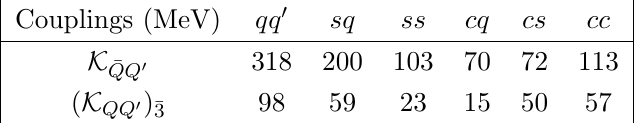
Table 7 . Spin-spin couplings, K (cid:22) and ( K QQ 0 ) (cid:22)3 , extracted from the spectra of mesons and QQ 0 baryons, respectively (borrowed from [15] and for cc from [61]). Here, q ( 0 ) denotes u - and d -quarks and isospin symmetry is